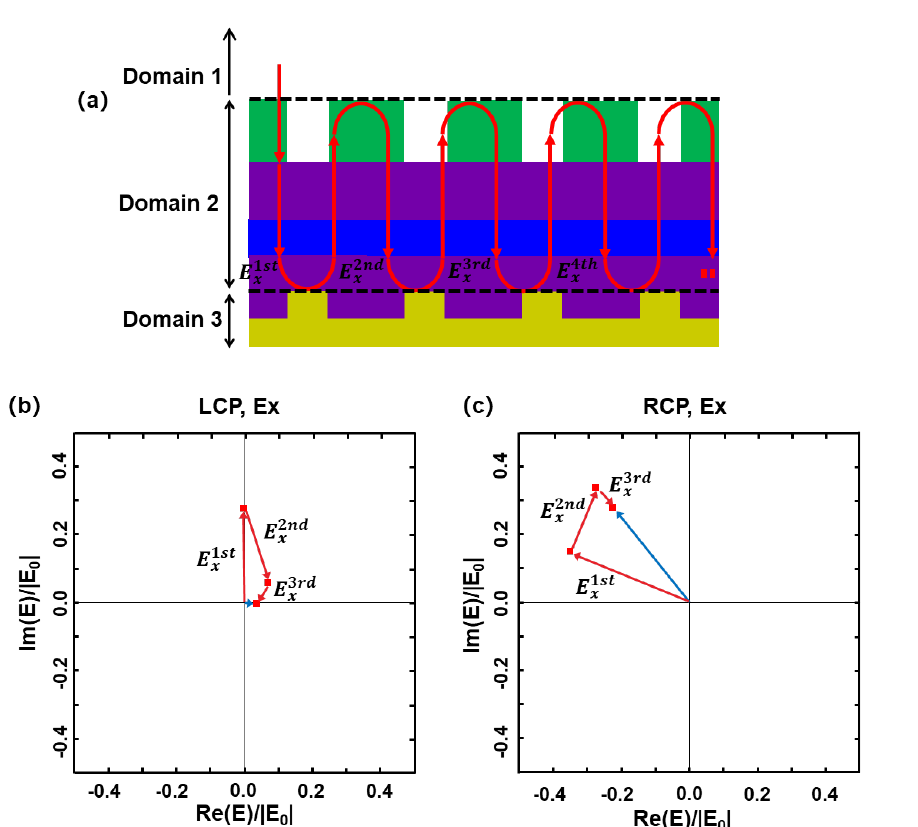
Figure 3. ( a ) Sketch of multiple reflections in the dielectric-metal-hybrid chiral metamirror inte-grated QWIP. ( b ) or ( c ) Evolution of the light field ( E x ) impinging at the metal grating after being reflected at the semiconductor/grating interface and the semiconductor/air interface for the 1st, 2nd, and 3rd time under LCP or RCP illumination.